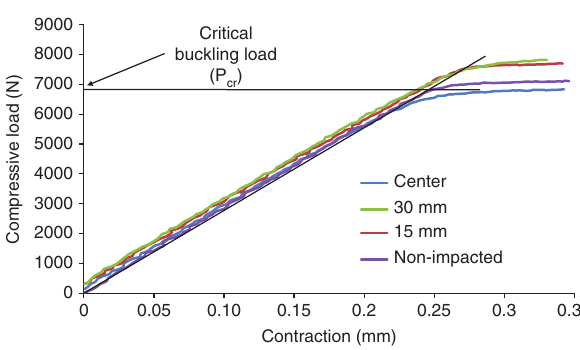
Figure 3 Variation of the force versus compressive displacement in the composite plates having different impact place (14 layers and 6